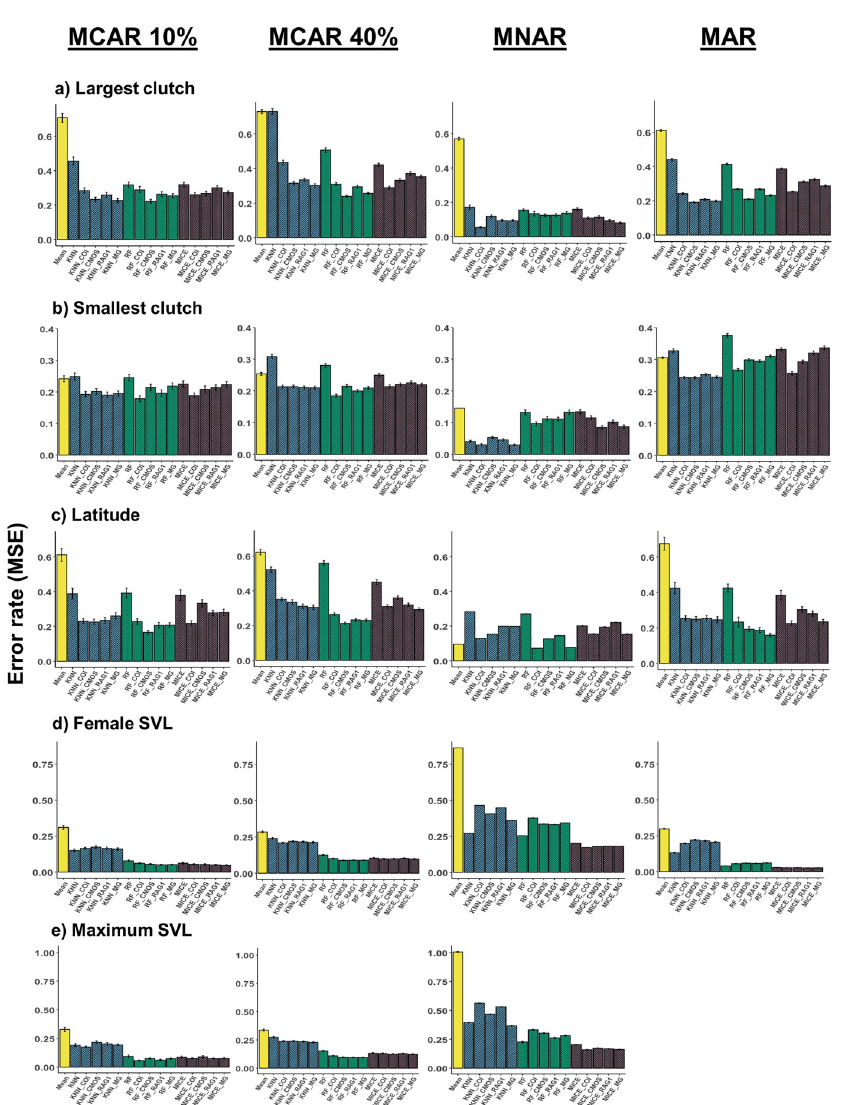
Fig 4. Imputation performance under different missingness mechanisms for numerical traits. Comparison of error rates for the methods mean/mode imputation, KNN , RF , and MICE under different missingness mechanisms with and without the addition of phylogenetic information. Phylogenetic information was added in the form of trees built from sequence data of COI, c-mos, RAG1, and a composite multigene (MG) tree. Performances were quantified using MSE for the numerical traits a) largest clutch, b) smallest clutch, c) latitude, d) female SVL, and e) maximum SVL. MSE values for each trait were averaged across 100 dataset replicates. 8.9%) and underrepresentation of the most common category (diurnal: 57.9% vs. 64.4%). Con- versely, the imputed data displayed a greater representation of observations in the most com- mon category compared to the original data (diurnal: 67.5% vs. 64.4%). For all numerical traits, the imputed data distributions followed the distributions of the original more closely than did the complete-case distributions (Fig 6B–6D and Table 1). Perhaps most apparent are the discrepancies in the maximum values in the complete-case data compared to those in the original and imputed data (e.g. for largest clutch, 68 vs. 88; for smallest clutch, 8 vs. 30). Although both complete-case and imputed data displayed reduced variance relative to the